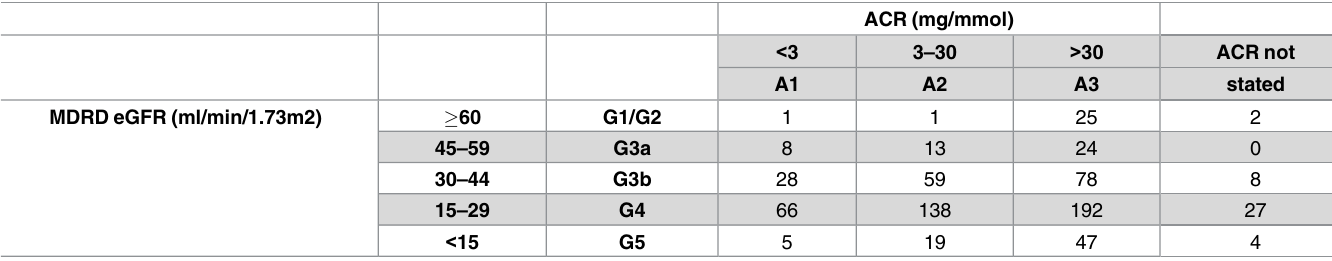
Table 2. Study population by Kidney DiseaseImproving Global Outcomes (KDIGO) classification